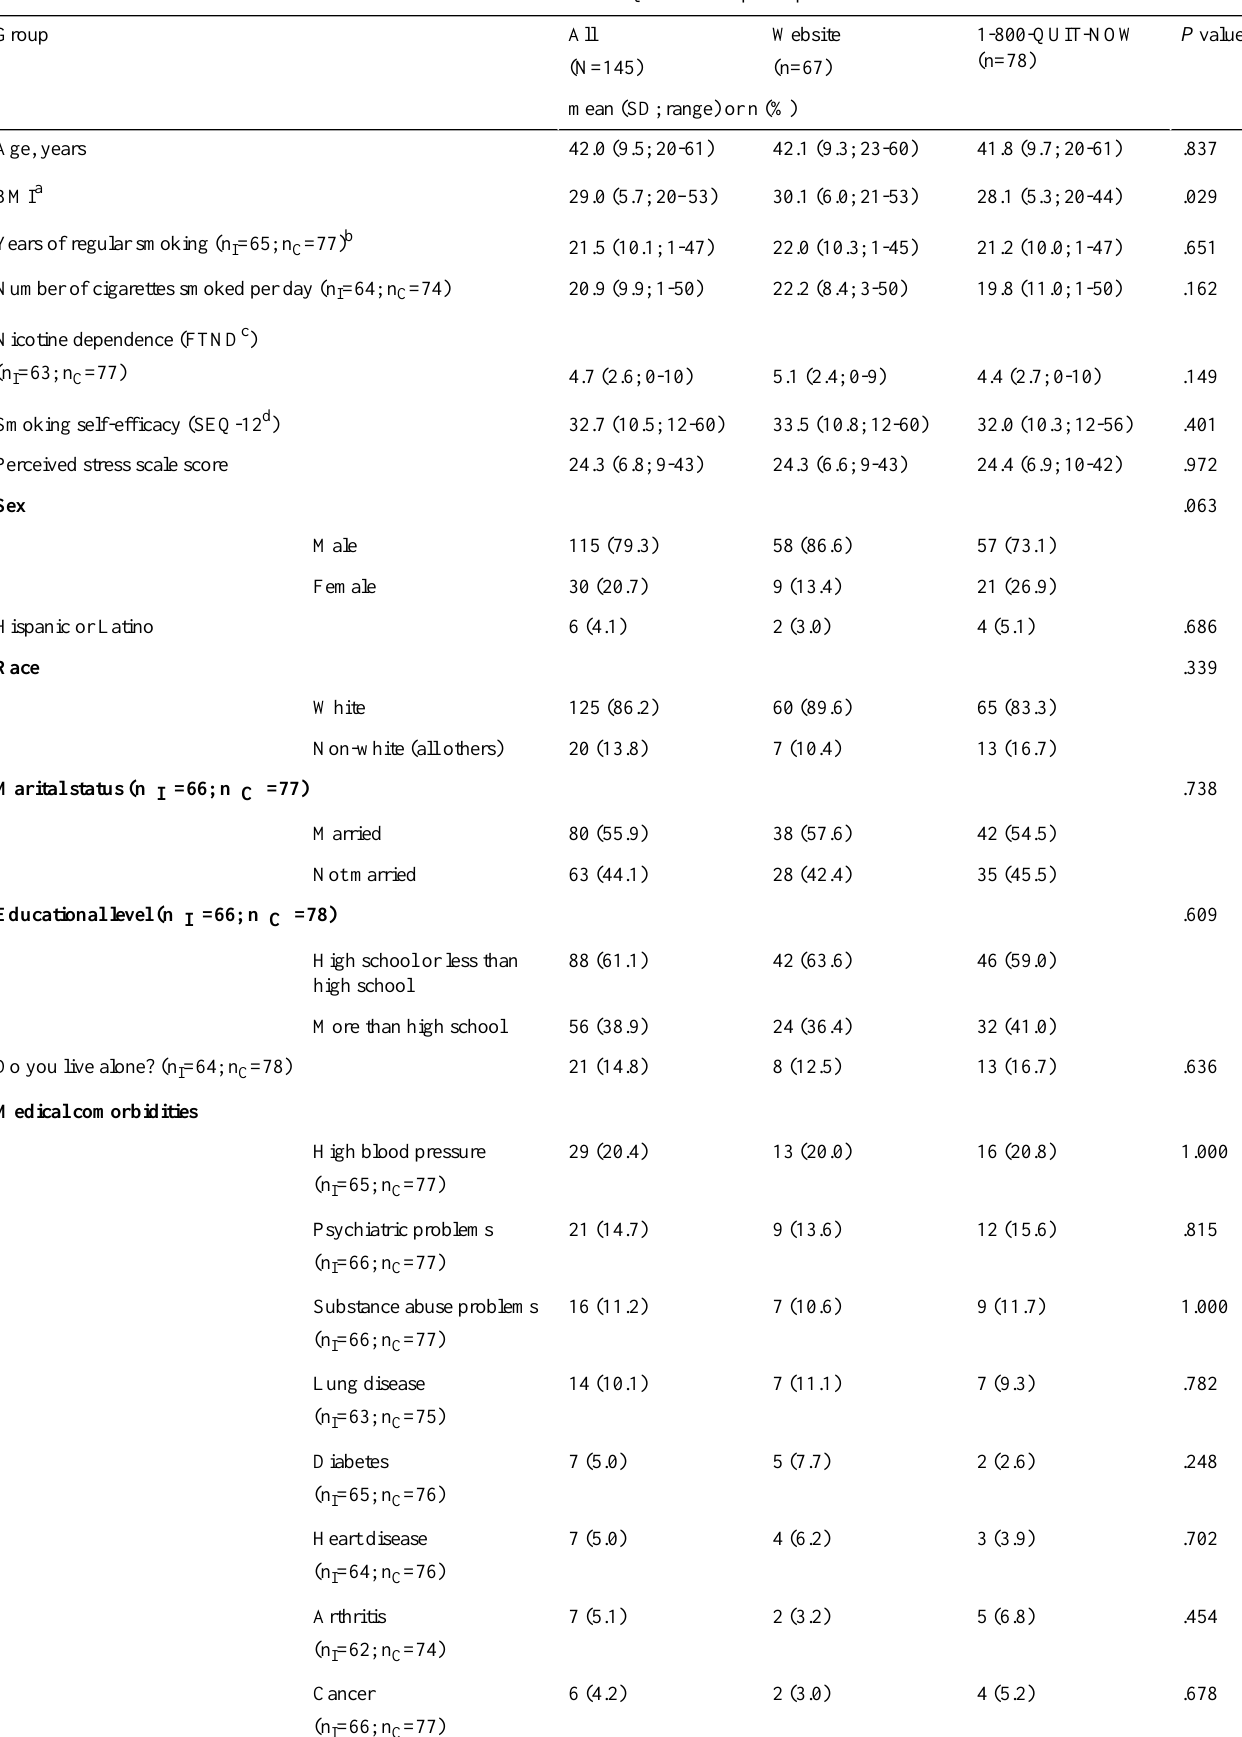
Table 1. Baseline characteristics of the Tobacco Tactics website and 1-800-QUIT-NOW participants.